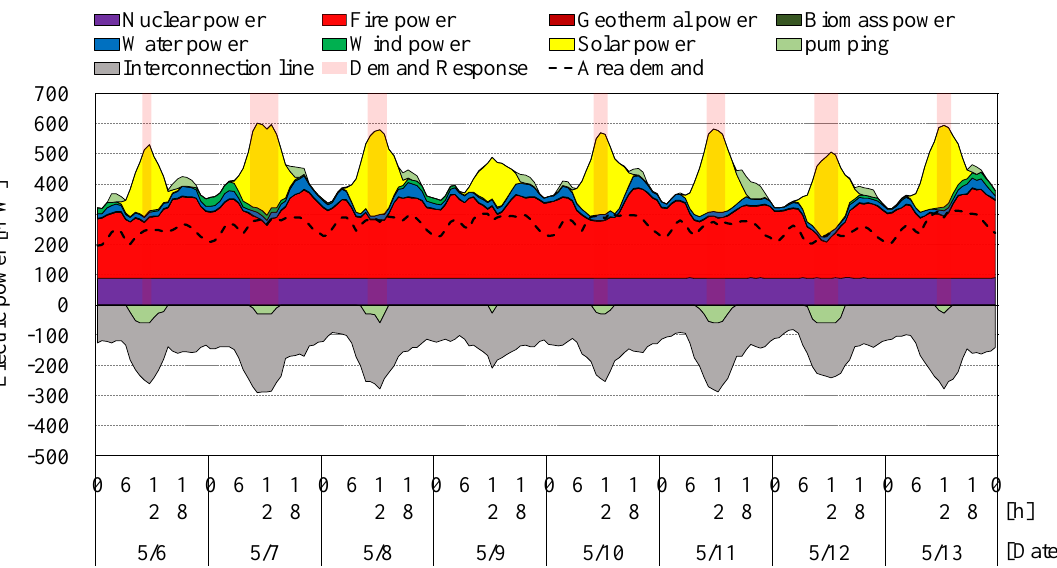
Figure 2. The DR occurrence change (One week in the interim period as the representative days).